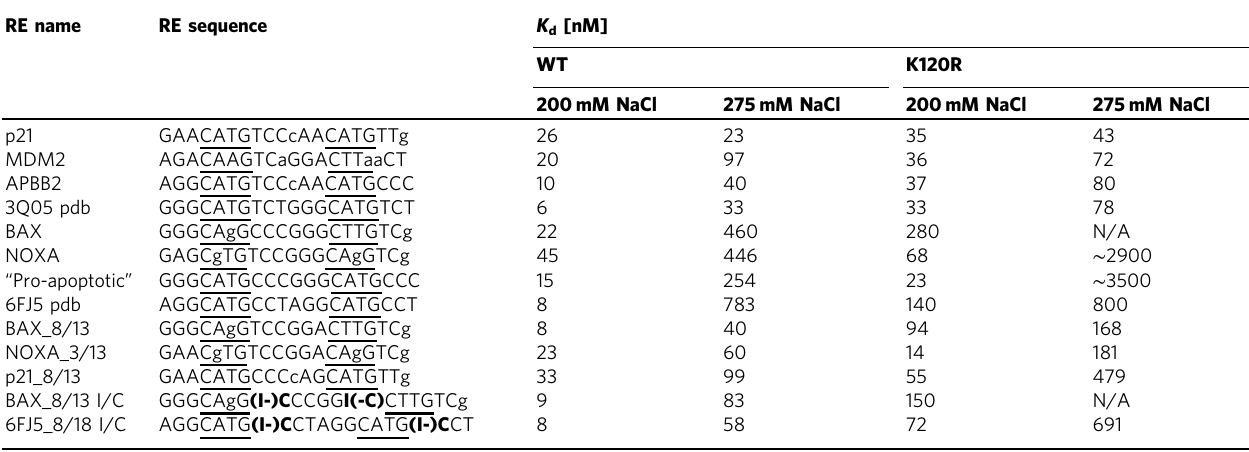
Lower-case letters in RE sequences indicate mismatches from p53 RE consensus. I (inosine) and C (cytosine) in bold indicate I/C bps. Letters in parenthesis indicate a nucleotide of the I-C bp found on the complementary strand. Underlined are core (CWWG) sequences. N/A not